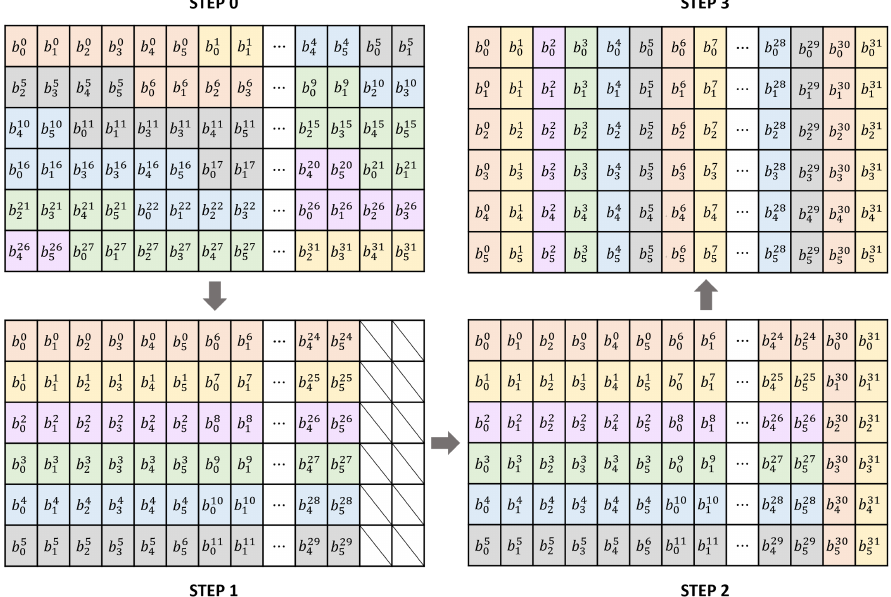
Figure 1. Plain text consisting of 32 blocks of 6 bits in 6 32-bit registers is reordered into a bit-slicing representation. A block of 6 bits is expressed as b i position of the